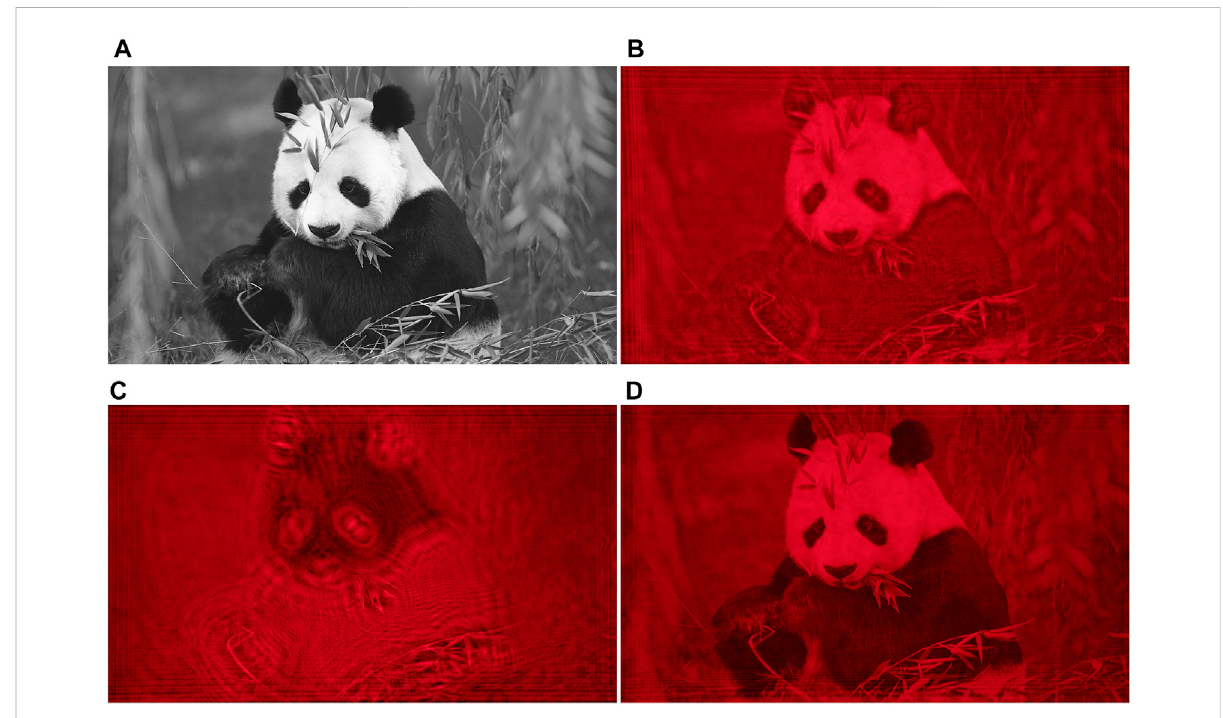
FIGURE 13 (A) Target image, (B) the ( 0th , 2nd ) and (C) the ( 0th , 1st ) diffraction order reconstruction of phase-only holograms with the strip-like encoding methodin y -axis,and (D) the ( 0th , 1st ) diffractionorderreconstructiongeneratedbytheproposedmethod.Thephysicalsizeofthereconstructionis 8.08 mm × 14.36